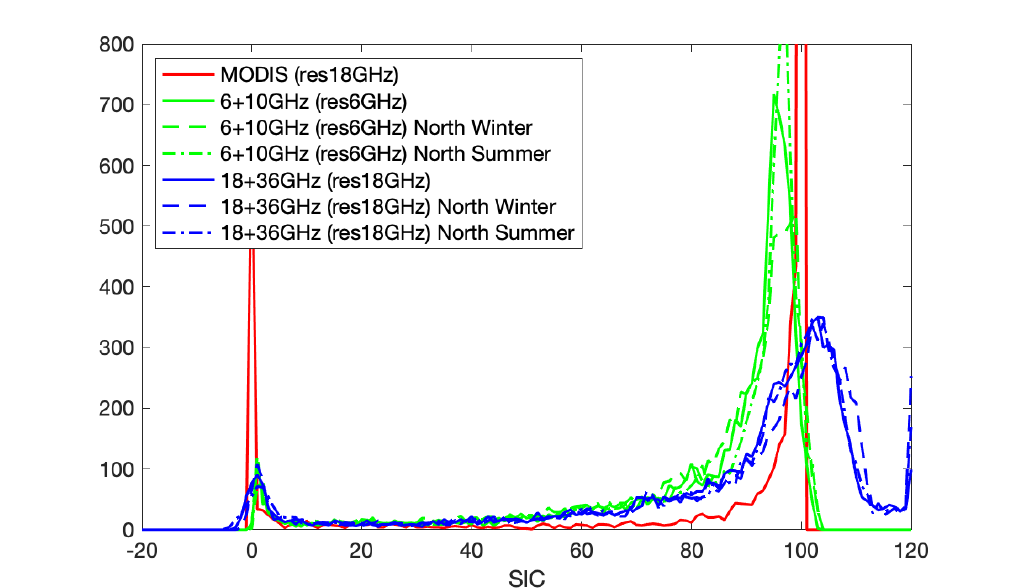
Figure 5. For the 20 April 2018 scene, the histograms of the SIC for MODIS at 18 GHz resolution in red, for our algorithms using the full RRDP with 6+10GHz in green (solid line), and for 18+36GHz in blue (solid line). Comparisons of our 6+10GHz and 18+36GHz AMSR2 algorithms using different subsets of the RRDP are also presented: limited to the north polar region for the winter season (dash lines) and then limited to the north polar region for the summer season (dash-dotted lines). The pixels that are cloud contaminated at more than 50% are excluded, as estimated by